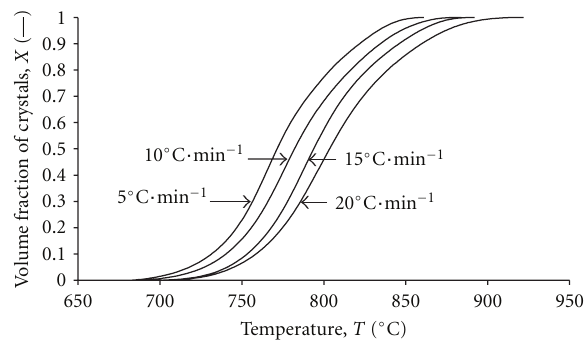
Figure 9: Measurement of the crystallization progress from nor- malization and integration of the DTA scans.